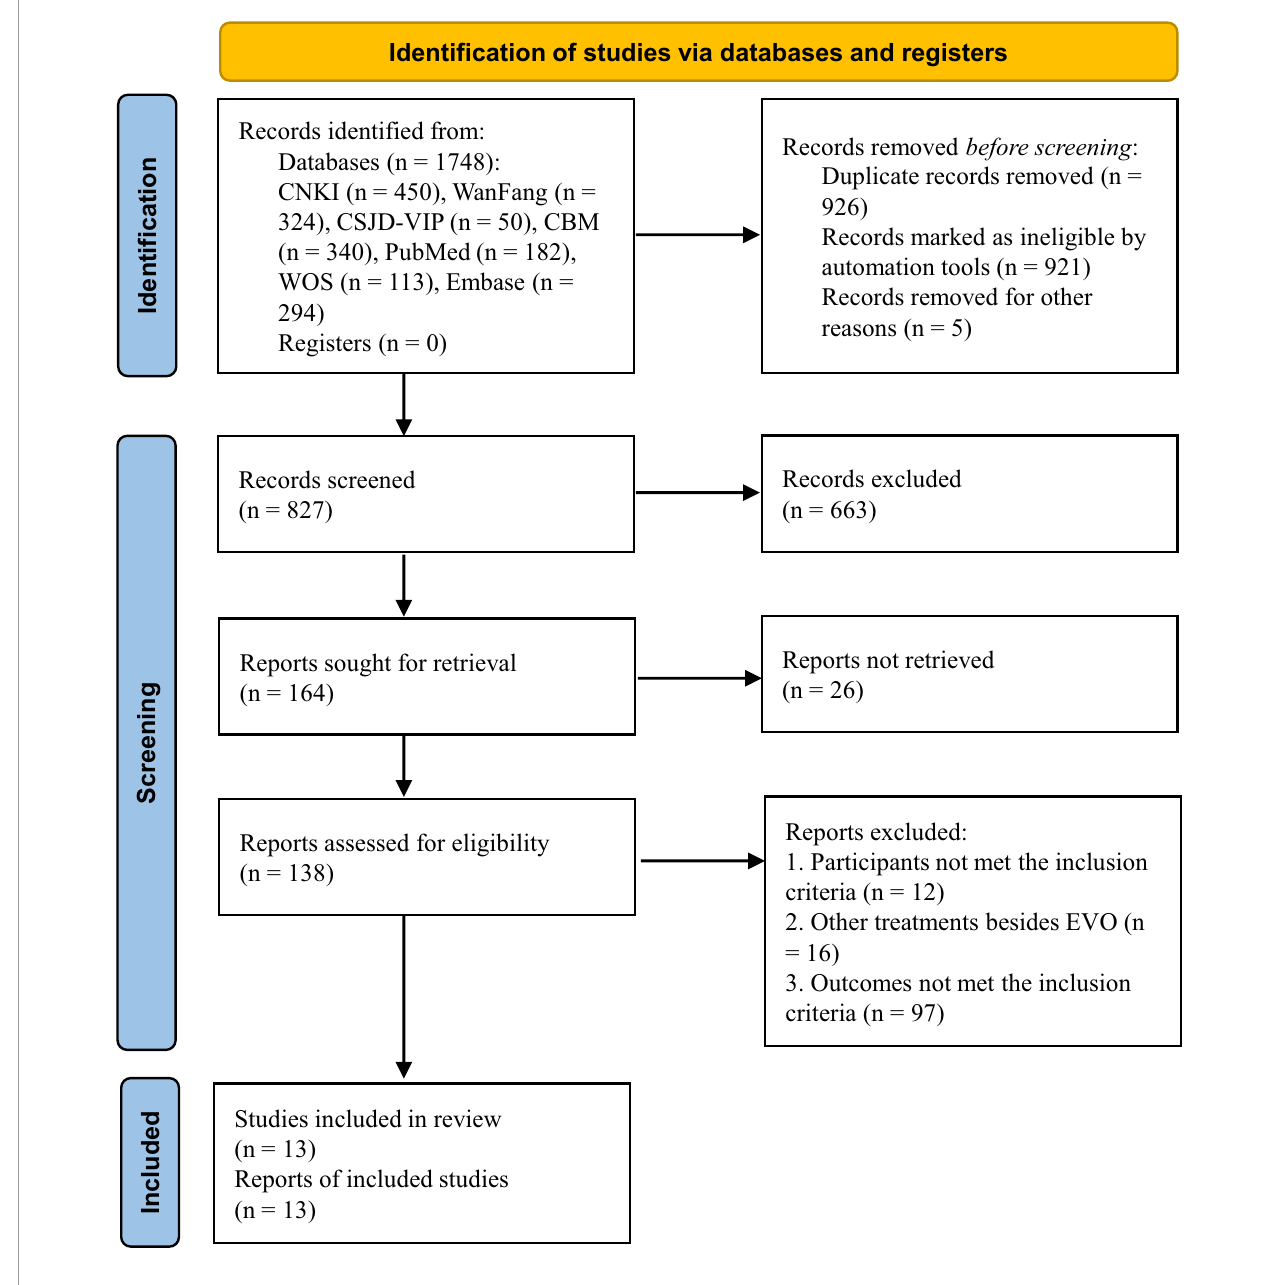
FIGURE 2 | Flow of the selection of